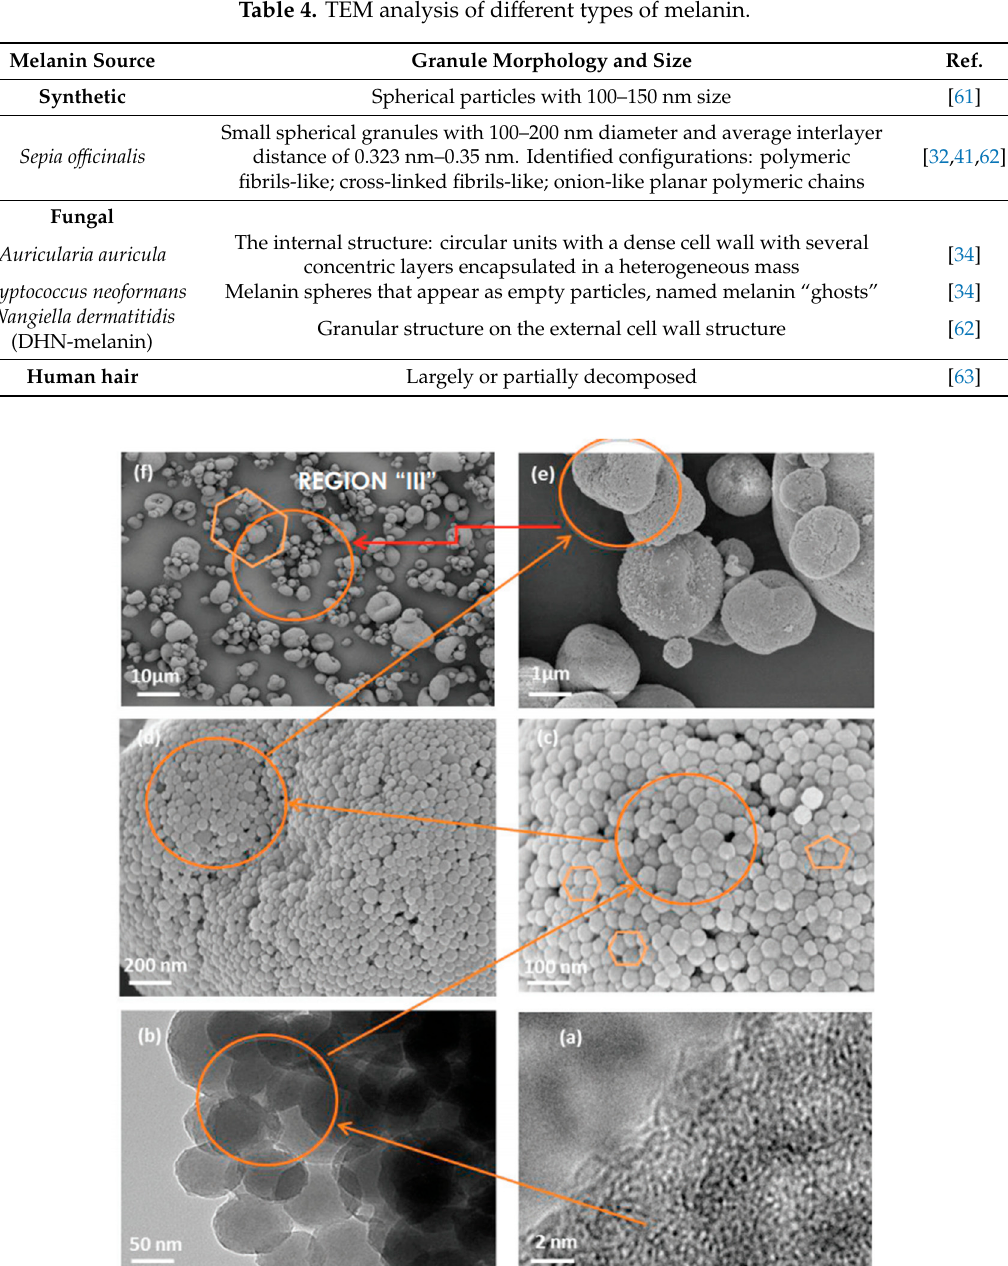
Figure 4. SEM and TEM images showing the multi-scale assembly hierarchical morphology of Sepia melanin at di ff erent magnifications; melanin nanoparticle scaled at 2nm ( a ); melanin nanoparticle highlighting the internal organization in a form of a block-copolymer-like structure ( b ); secondary self-aggregation of melanin nanospheres in polydisperse large clusters ( c – e ); deflated clusters with a wide size distribution form of self-aggregates ( f ) (Reprinted with permission from Ref.